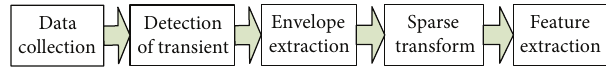
Figure 1: The flowchart of feature extraction for wireless transmitters.